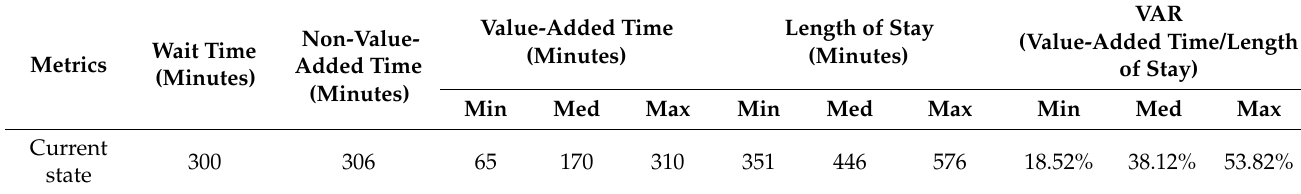
Table 1. Metrics current state.